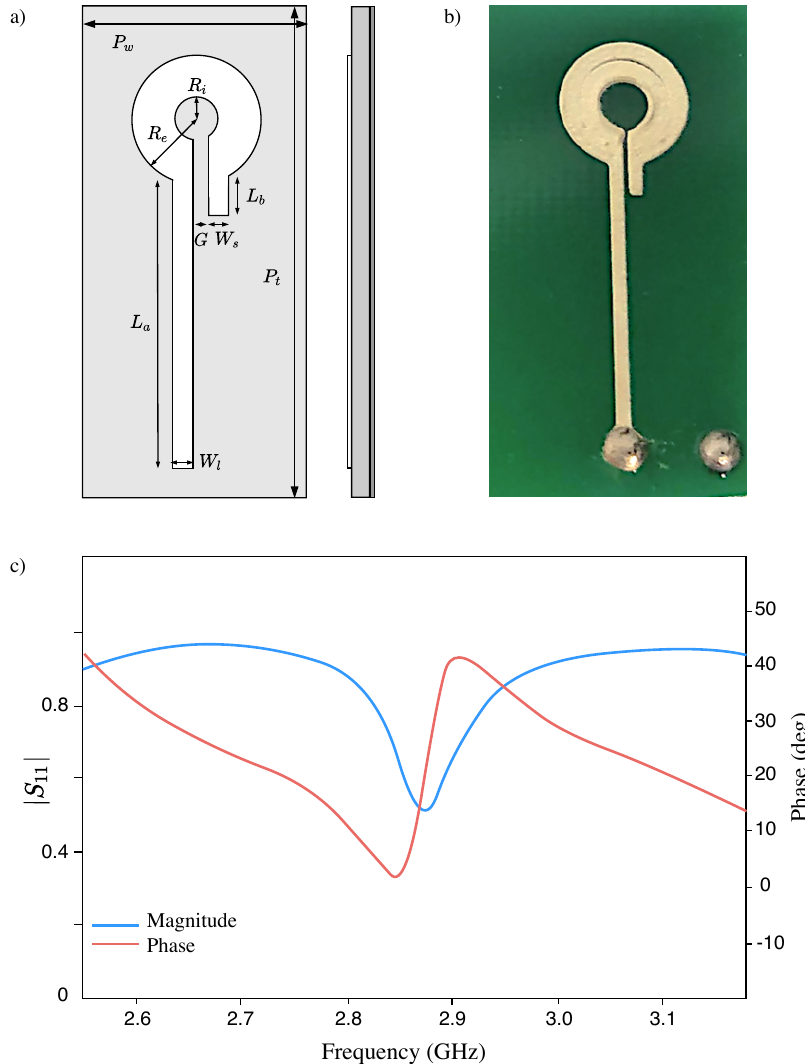
Figure 5. Schema of a top view and a cross section of the resonator ( a ). The flat ring resonator is made up of a radiating patch, a dielectric substrate, and a grounding plate ( b ). The radiating ring structure was printed with silver on a substrate 1.3 mm PCB flat laminated composite substrate, made from a non-conductive material, and the grounding plate, a 0.08 mm thick copper foild. The geometric dimensions (mm) of the resonator are: L a = 16, L b = 2.1, W l = 0.5 W s = 0.5, G = 0.2, P w = 10.2 mm and P l = 30 mm. The inner and outer radius of the ring are: R i = 1.3 mm and R e = 3.7 mm respec- tively. S 11 is the resonator reflection coefficient ( c ), it is a ratio and therefore, a non-dimensional parameter but usually the magnitude is specified in dB (20 log | S 11 | ), for instance 0 dB indicates a magnitude | S 11 | = 1 which means that all the radiation applied is reflected and it is the case for this specific resonator at all frequencies different to the 2.87 Gz. The phase in red and the magnitude in blue show the response as